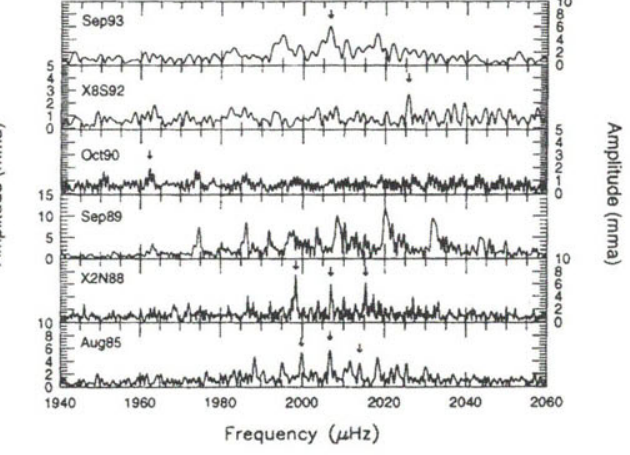
Fig. 8. Fourier transform of the 500 s region in G 29-38 data. Twice this region has been resolved into a triplet that shows similar behavior to the 400 s triplet. The central m = 0